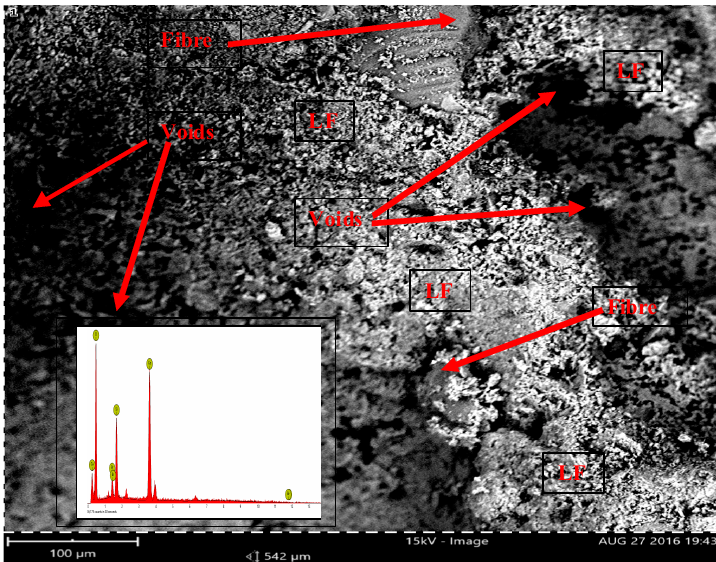
Figure 7. SEM analysis and EDS spectra of sample D (LF—latex films).